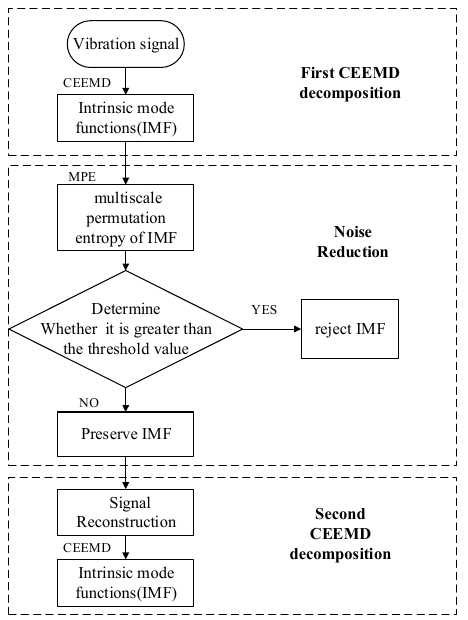
Figure 1. Algorithm flowchart of improved complementary ensemble empirical mode decomposition (ICEEMD).